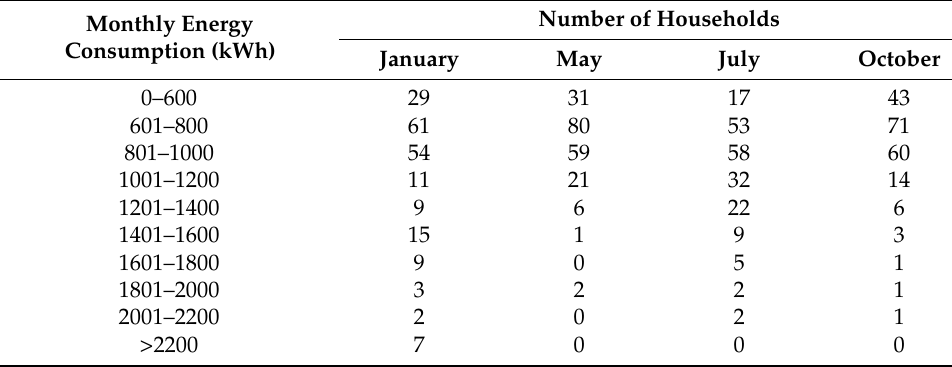
Table 1. Distribution of households’ monthly energy consumption.